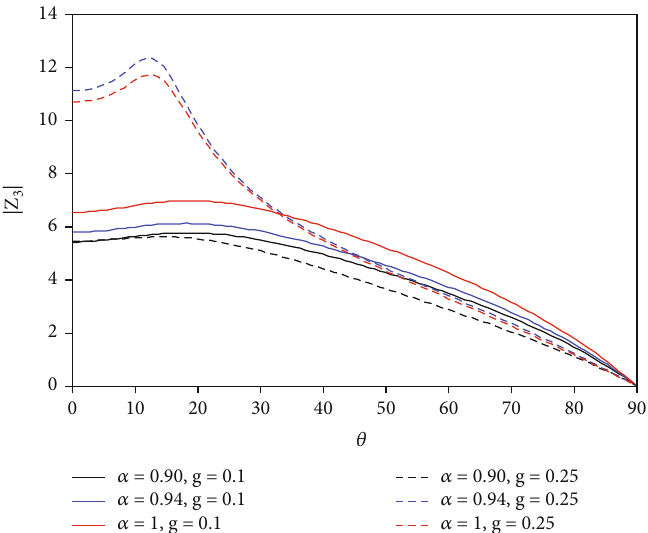
j concerning the angle of incidence θ for various values of the fractional parameter of the 3